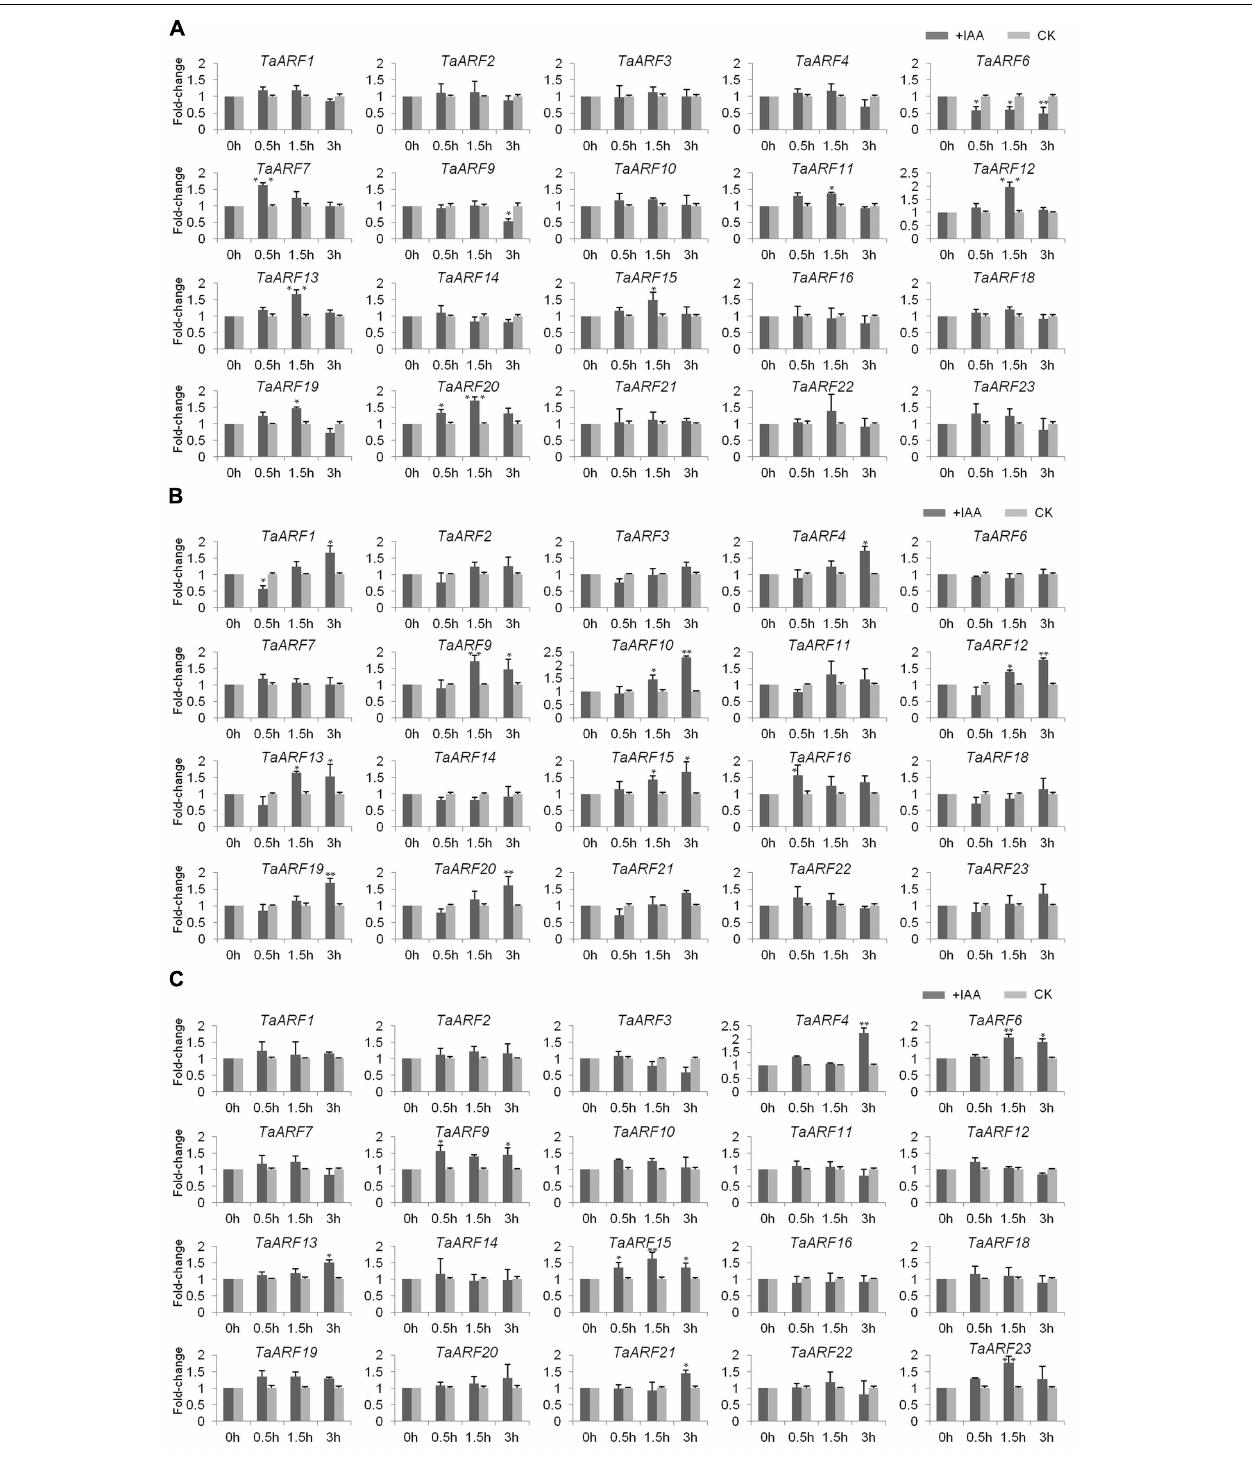
FIGURE 3 | Induction (fold change) of TaARF genes in response to exogenous auxin stimuli in the roots (A) , stems (B) , and leaves (C) of wheat seedlings. The roots, stems and leaves of wheat cultivar “Chinese Spring” at the three-leaf stage were harvested at 0, 0.5, 1.5, and 3 HAT; the plants were treated with 10 µ M α -NAA solution or distilled water (mock treatment). The relative expression level of each gene was measured three times and then normalized to that of the GADPH gene, after which the levels were analyzed using the fold-change method. Paired t -tests were used to detect significant differences in relative expression levels of genes between the auxin treatment and the mock treatment at each time point. The asterisks indicate significant differences, and the error bars indicate the SD.